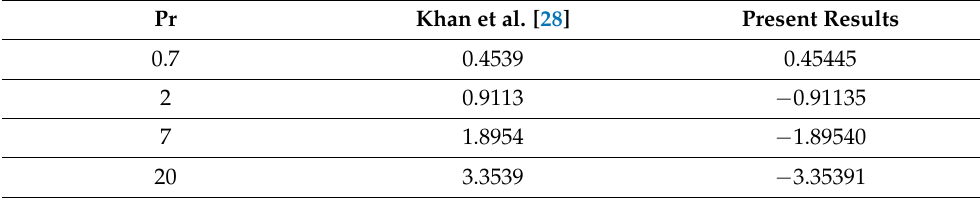
Table 4. Comparison of numerical values of − θ (cid:48) ( 0 ) at λ = ε = Nb = Nt = 0, n =